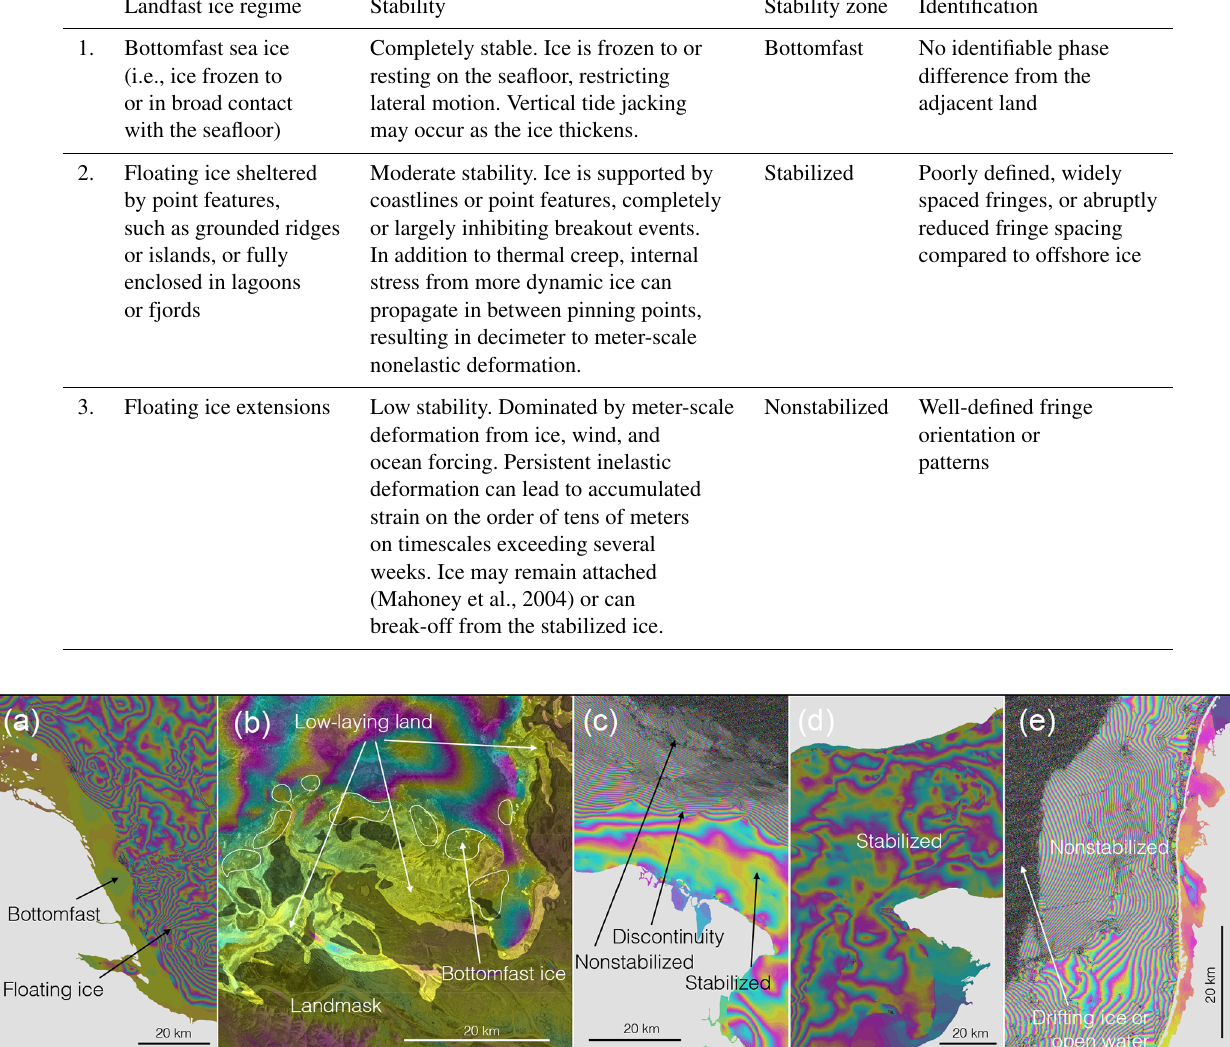
Table 1. Landfast sea ice stability regimes and assigned stability zones identified using InSAR.